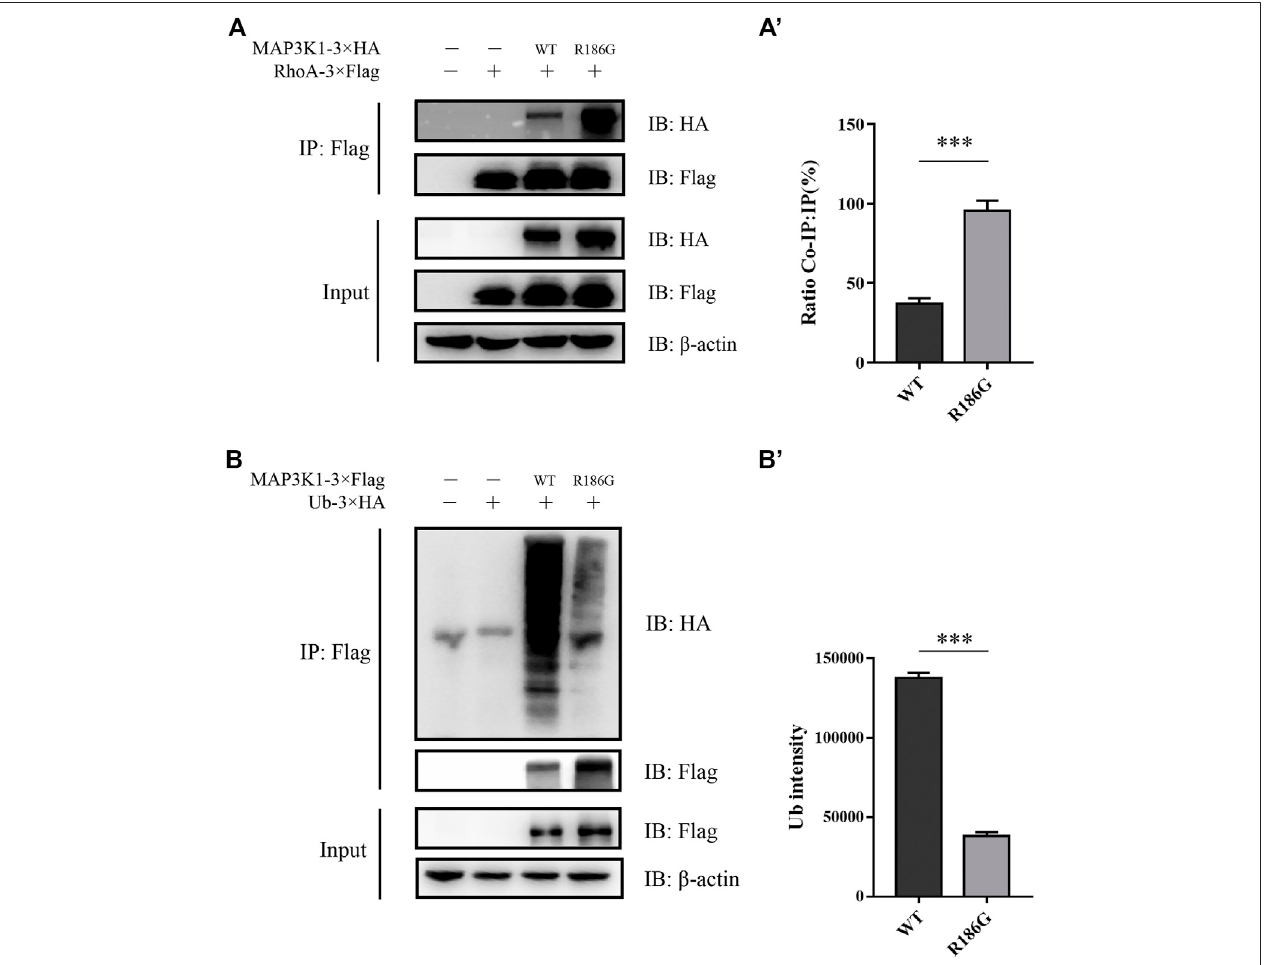
FIGURE5| Co-IP assay analysisoftheinteractionbetween MAP3K1 and RhoA orUb. (A) Co-IP assay analysisoftheinteractionbetween MAP3K1 wild-type and R186G variant with RhoA. Cells were co-transfected with MAP3K1-3×HA and RHOA-3×Flag in HEK293T cells; Some of the lysates were subjected to input assays to assess β -actin, MAP3K1-HA, and RhoA-Flag protein levels, and the remainder were subjected to IP assays. (A 9 ) Quanti fi cation of Co-IP western blots. Band intensities weredeterminedand used tocalculatethe relative ratio ofCo-IP toIP signal.Data shown are averaged percentages±SEM( n = 3independent experiments, *** p < 0.001byMann-Whitney U test). (B) TheubiquitinationofMAP3K1wild-typeandR186GvariantsinHEK293TcellswasCo-IPthenimmunoblotted. (B 9 ) Quanti fi cationof MAP3K1 polyubiquitination by ImageJ. Data shown are Mean ± SEM ( n = 3 independent experiments, *** p < 0.001 by Mann-Whitney U